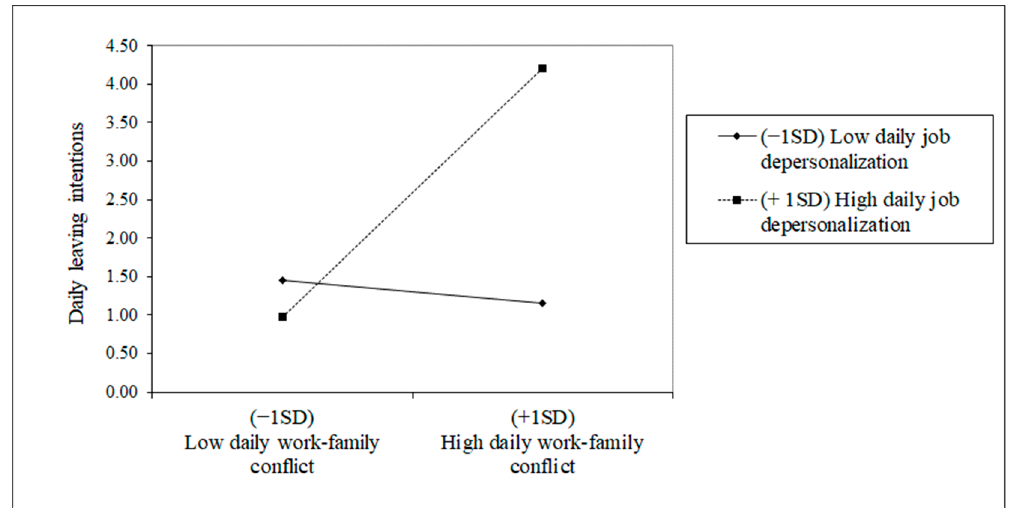
Figure 3. Interaction effects of Daily work-family conflict and Daily job depersonalization in explaining Daily leaving intentions.